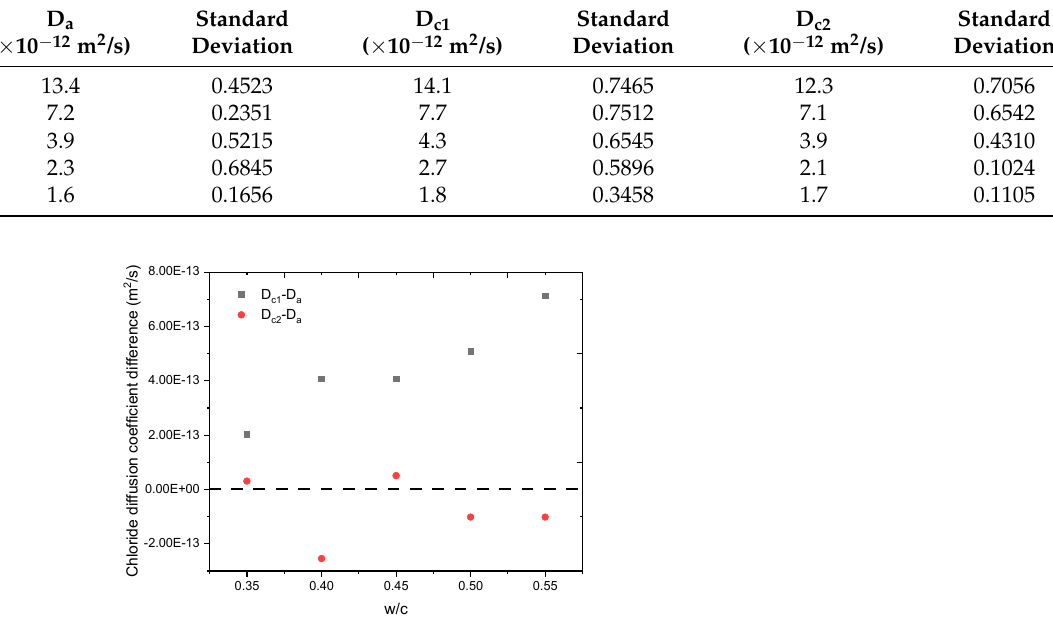
Figure 8. Chloride diffusion coefficient with different determination methods. Table 5. The calculated effective chloride diffusion coefficient of all mixtures.